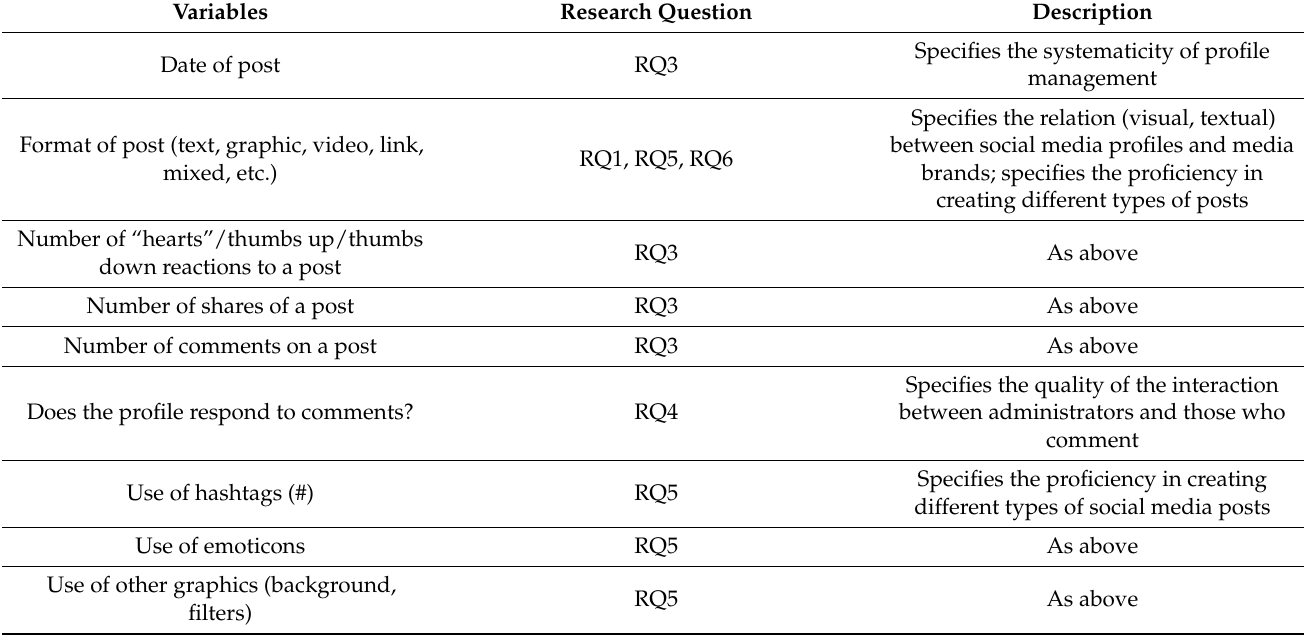
Table 1. Assumptions for content analysis of IG and YT profiles—stage